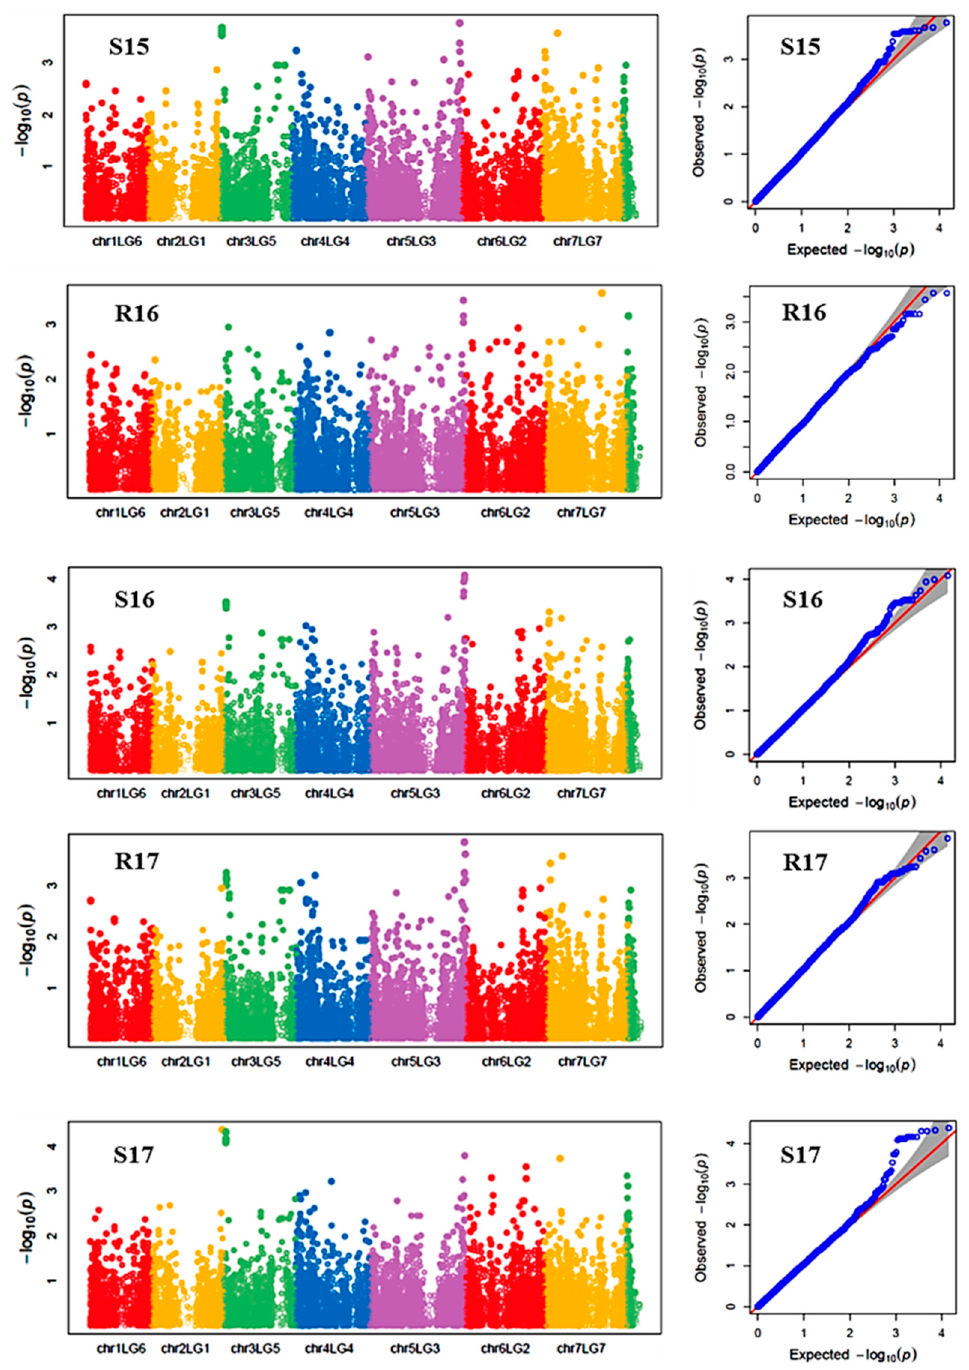
Figure 3. Manhattan plots and the corresponding Q-Q plots representing the identification of SNP markers associated with reproductive stem length. The Manhattan plots are based on association of 15608 chromosomal and 1269 non-chromosomal SNPs with reproductive stem length of 135 pea accessions in the multi-year, multi-environment trials. Note: R16, Rosthern in 2016; R17, Rosthern in 2017; S15, Saskatoon in 2015; S16, Saskatoon in 2016; and S17, Saskatoon in 2017. Of all the MTAs that were observed in > 60% of the environments, the following markers had the greatest percent variation averaged over the selected environments for the respective traits: Chr5LG3_566189589 (13% PV) and Chr5LG3_449362407 (11% PV) for SPAD; Chr6LG2_469101917 and Chr7LG7_263964018 each with 9% PV for PRI; Chr4LG4_415994869